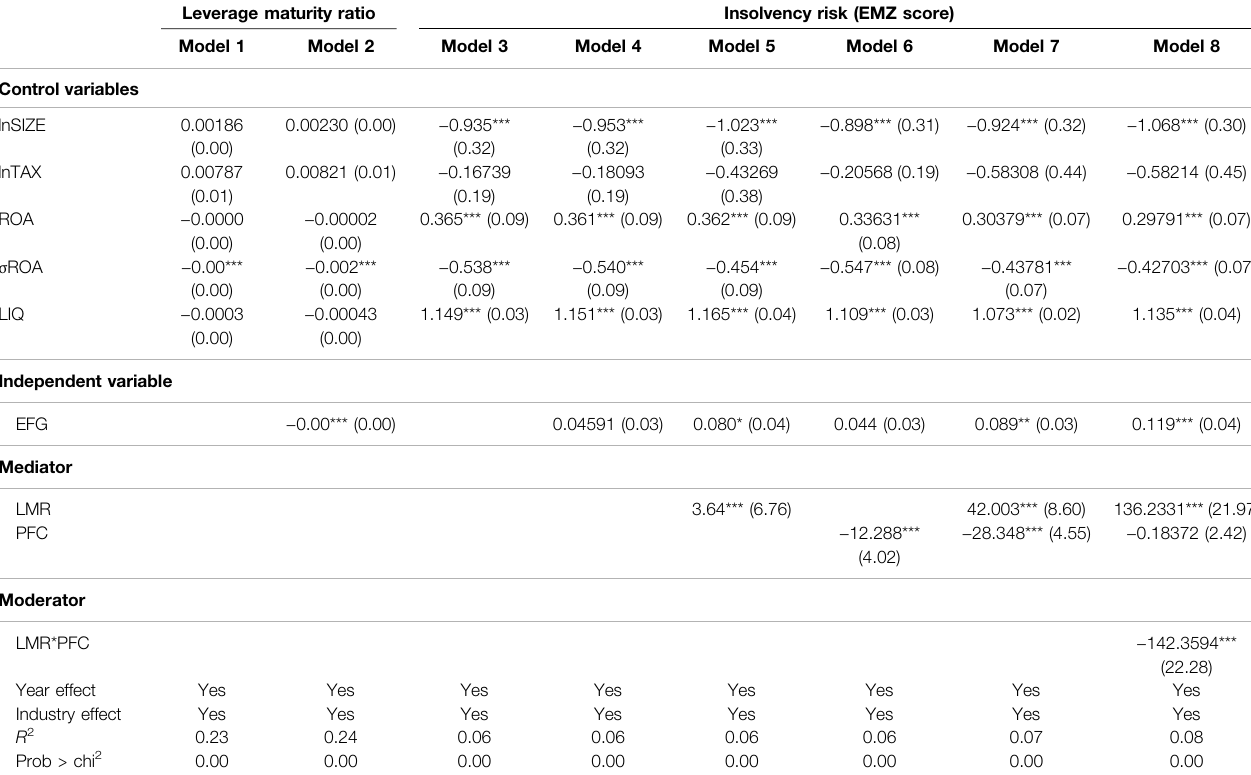
TABLE 7 | Hierarchical PCSE regression results with EFG as